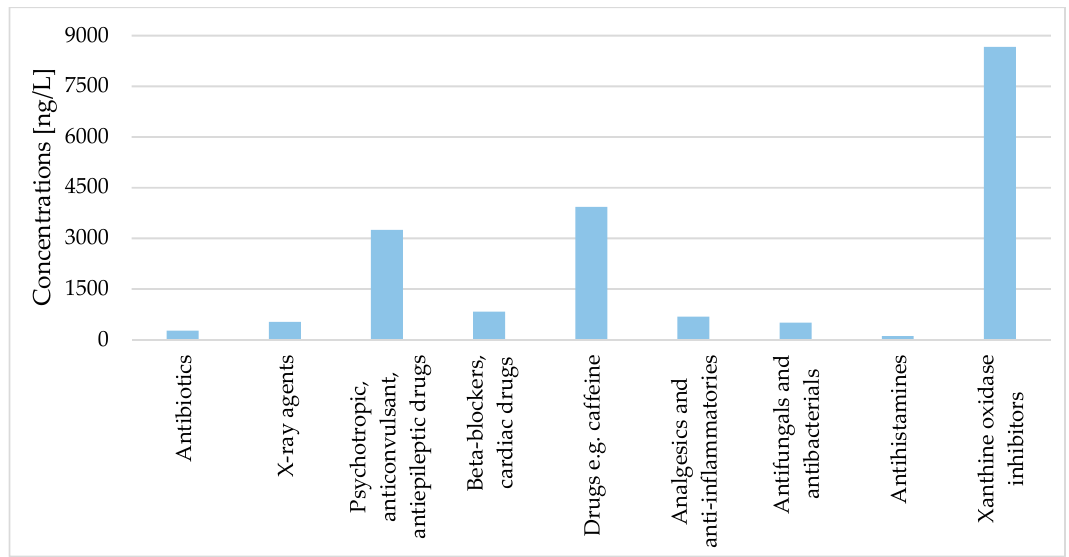
Figure 2. Concentrations of carbamazepine ( a ), gabapentin ( b ), sulfamethoxazole ( c ), and tramadol ( d ) for 3 sampling sessions. Water 2019 , 11 , x FOR PEER REVIEW